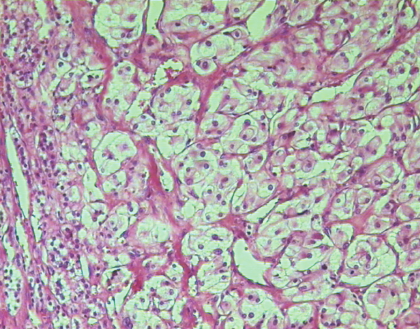
Figure 3: The lobulated hypercellular tumor is composed of large, polygonal cells with a low nuclear/cytoplasmic ratio and a grainy basophilic cytoplasm. The tumor is encircled by cells that form the cortical region of the adrenal gland. The mass is well demarcated, with no capsule or pseudocapsule.